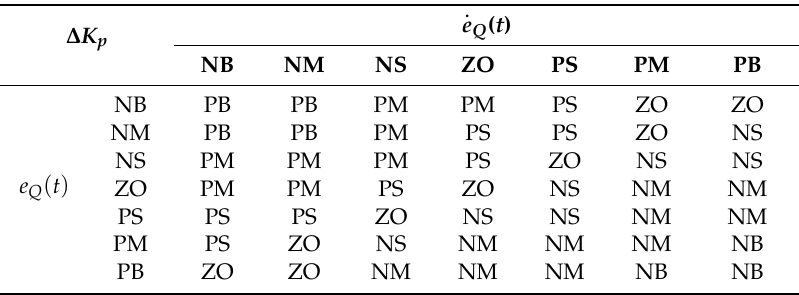
Table 1. Fuzzy control rules for ∆ K p